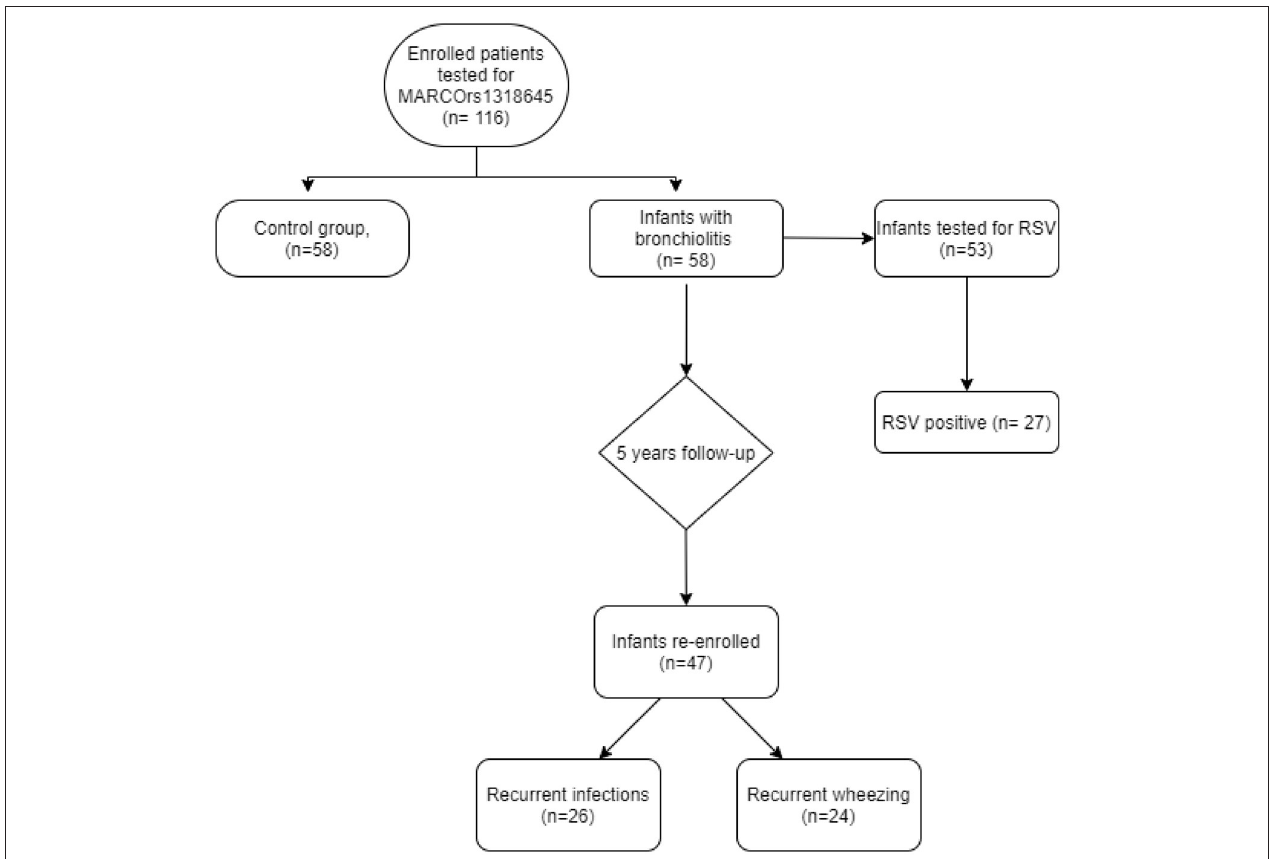
FIGURE 1 | Enrollment process and